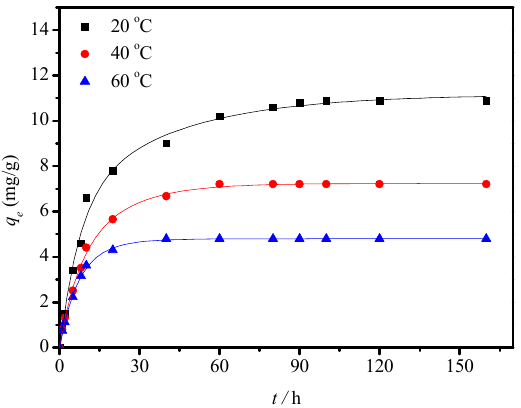
Figure 6. Influence of contacting time on the adsorption of HCHO on CGC. Adsorption conditions: 0.5 g CGC, 20 °C, 28 mL/min, C inlet = 39.2 mg/m 3 , RH = 40%.